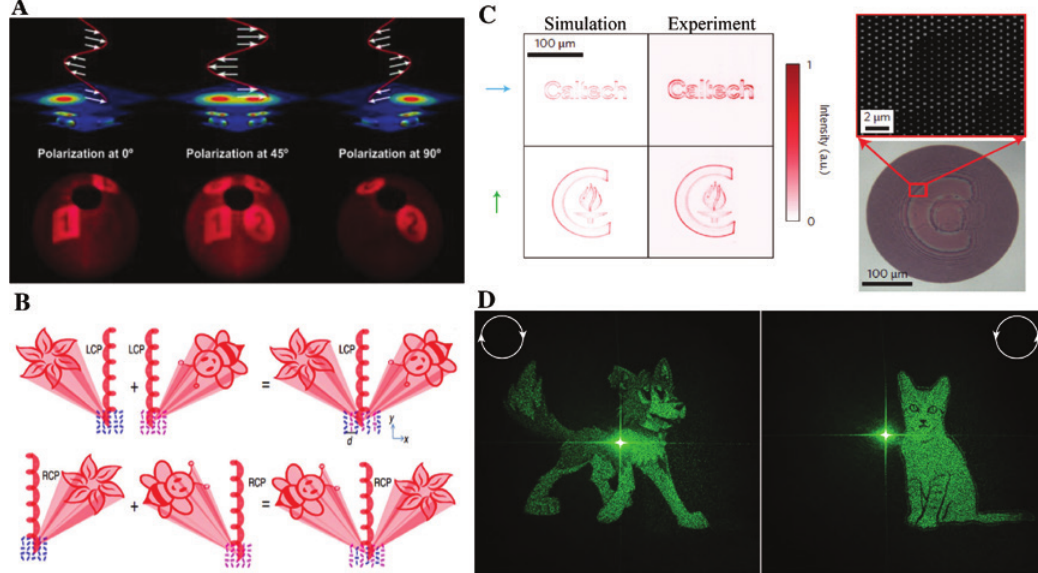
Figure 6: Polarization multiplexing. (A) Linear polarization multiplexing by superimposing the two orthogonal arrays of the nanorods within one metasurface [69]. (B)